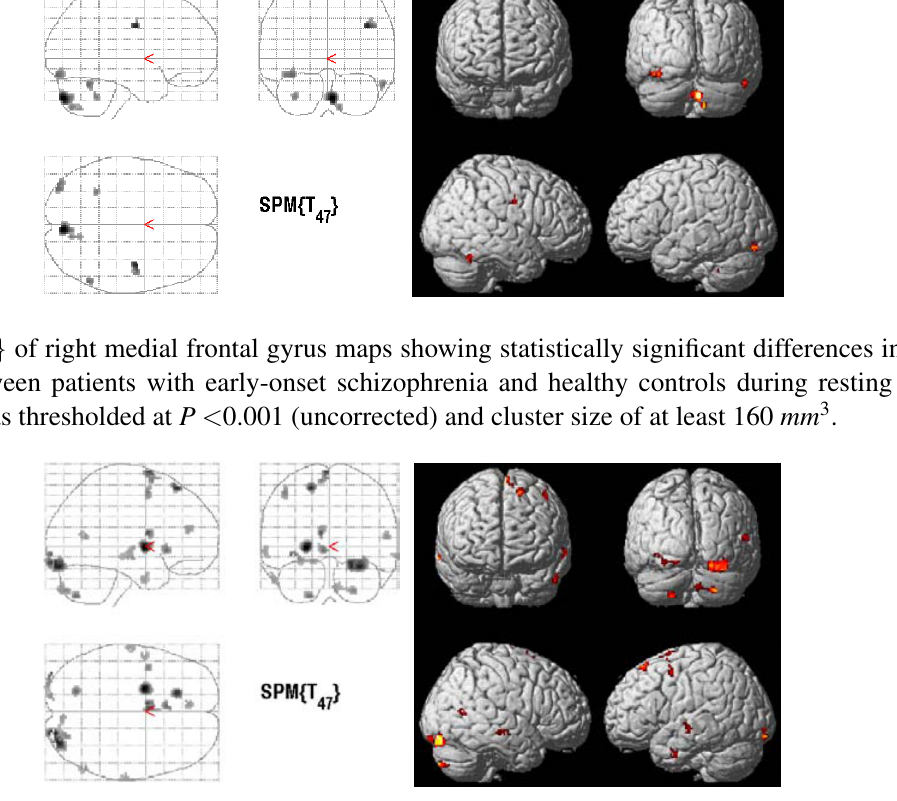
Figure 5: SPM { t } of right subgyral maps showing statistically significant differences in functional connectivity between patients with early-onset schizophrenia and healthy controls during the resting state. The statistical map was thresholded at P < 0.001 (uncorrected) and cluster size of at least 160 mm 3 .